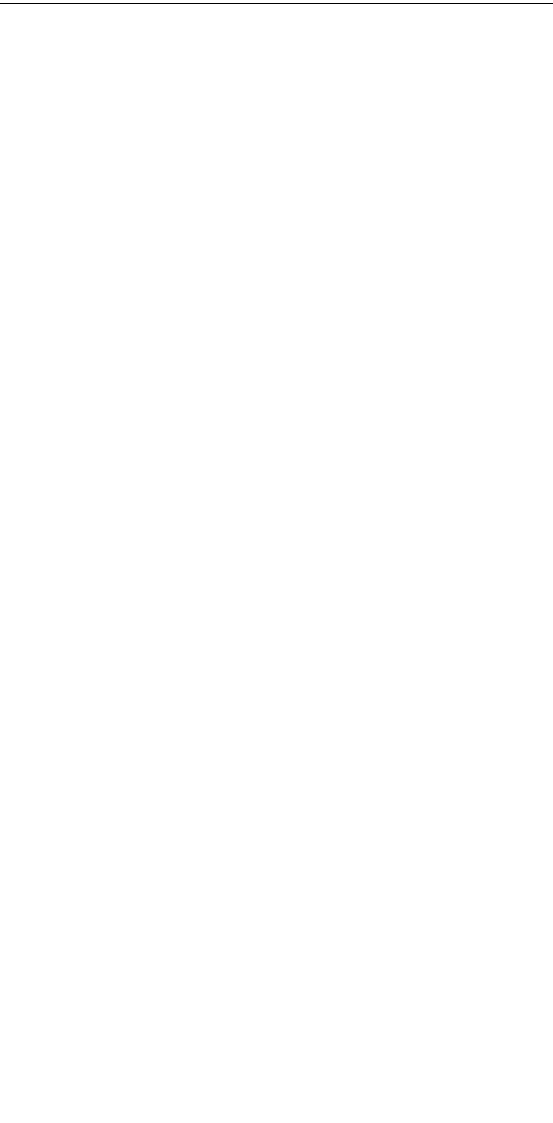
FIGURE A3 | pGoldenGate-MCY2